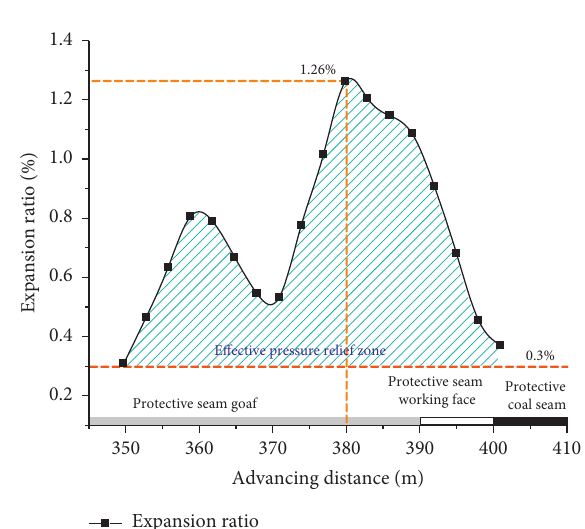
Figure 19: The curve of the average expansion range of 350m ∼ 400m intercepted by the protected